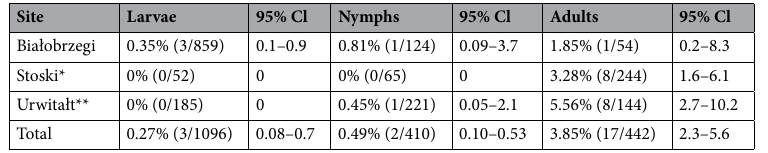
Table 2. Comparison of B. canis prevalence between juvenile and questing adult ticks D. reticulatus in endemic sites. *Stoski + Franciszków together for juvenile tick stages. **Urwitałt + Tałty together for juvenile tick